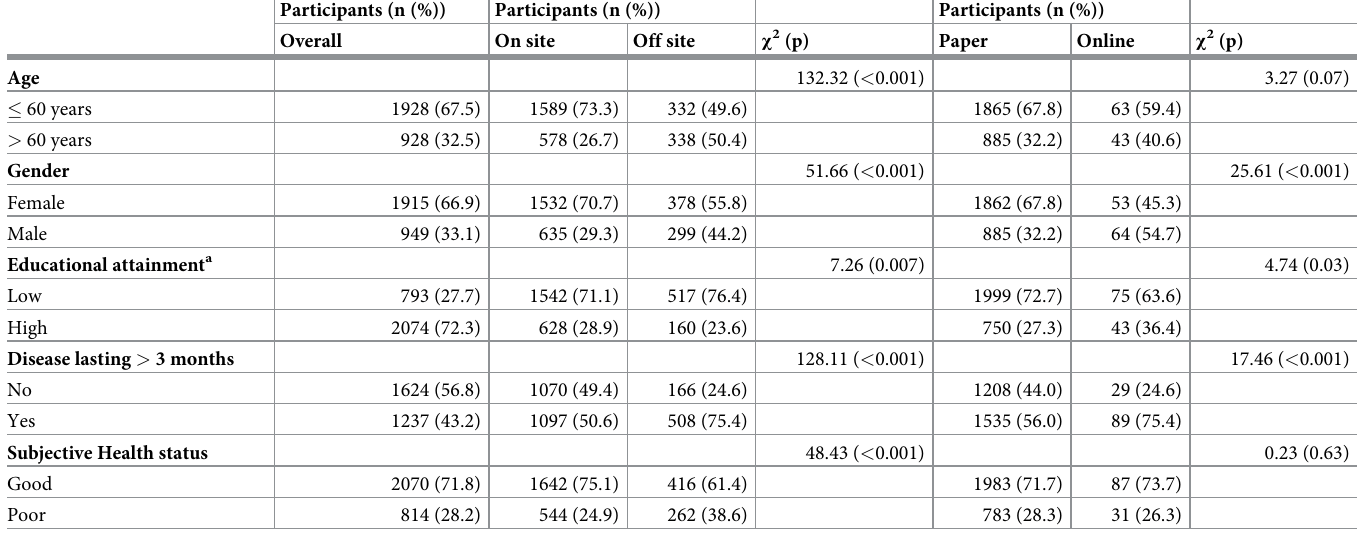
Table 2. Patient characteristics across survey